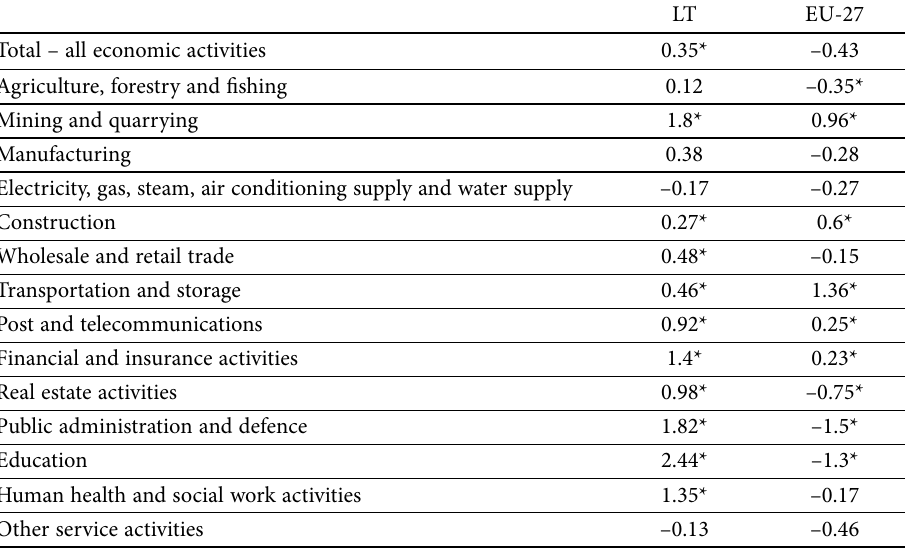
Table 2. Elasticity coefficient by economic activity in the period